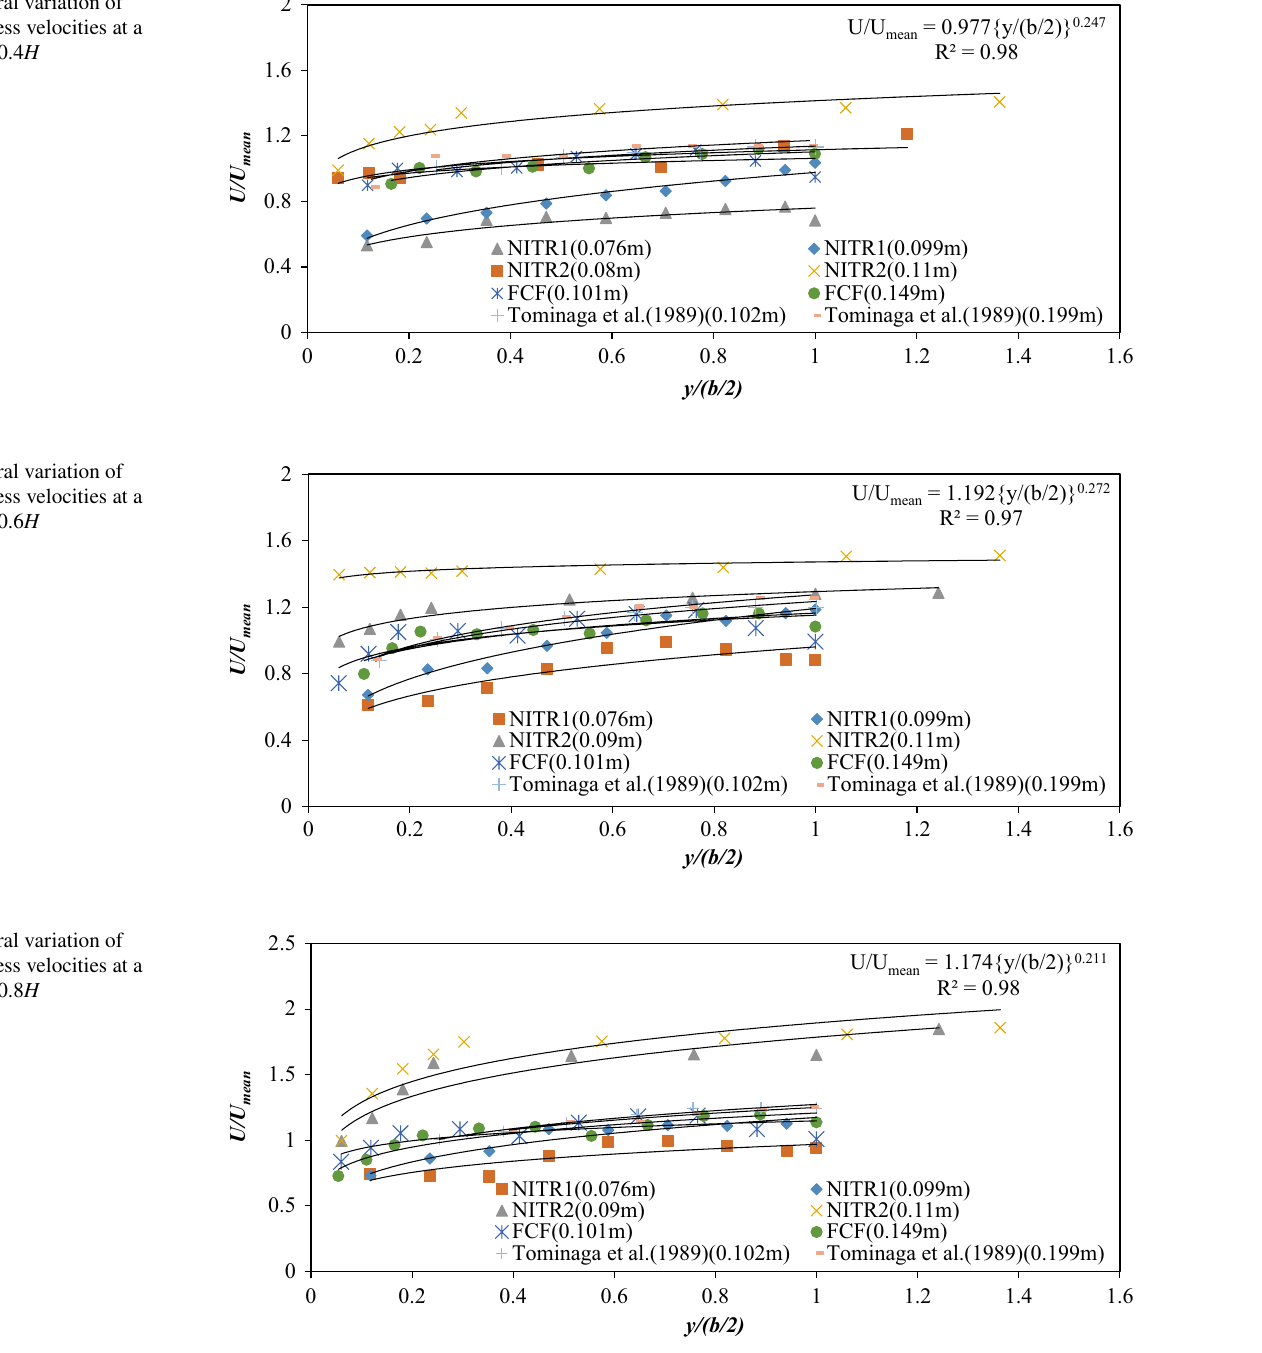
Fig. 5 Lateral variation of dimensionless velocities at a position of 0.4 H